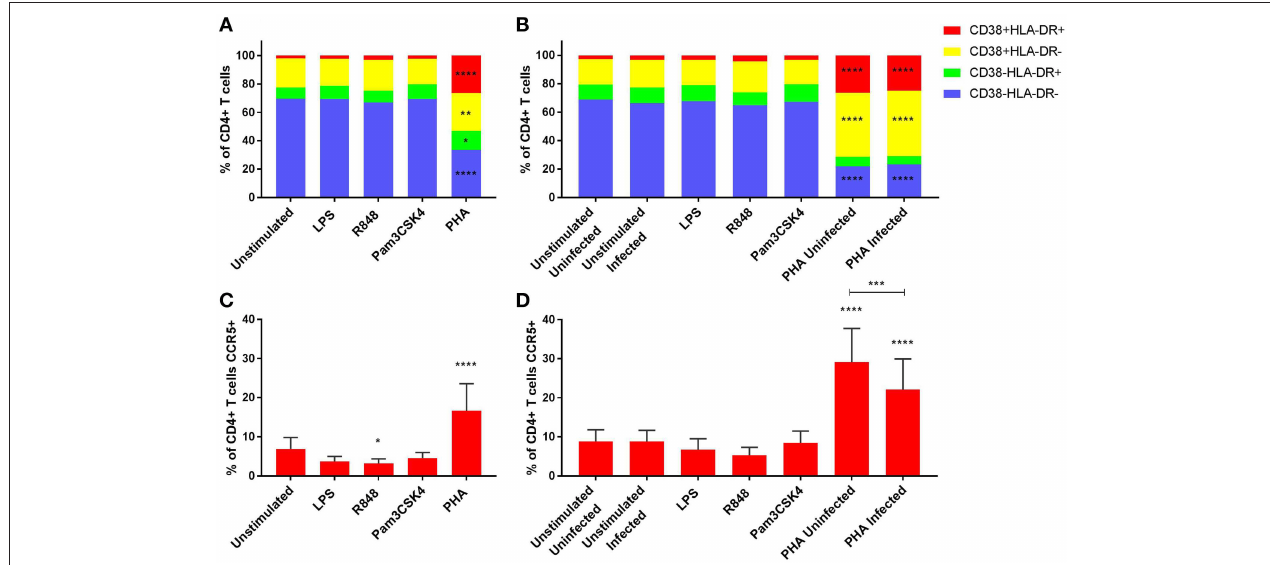
FIGURE 1 | Activation profiles (A,B) and CCR5 expression (C,D) of CD4 + T cells on day 3 prior to HIV infection (A,C) and day 5 post HIV infection (B,D) . PHA was used at a final concentration of 10 µ g/ml. TLR agonists were used at a final concentration of 2 µ g/ml. A repeated measures two-way ANOVA with Dunnett’s multiple comparisons test was used for immune activation, and an ordinary one-way ANOVA with a Dunnett’s multiple comparisons test for CCR5 expression. Significance is displayed as * p < 0.05, ** p < 0.01, *** p < 0.001, **** p ≤ 0.0001 compared to the unstimulated/unstimulated infected control, unless otherwise shown. Sample size, n = 5, 4 donors run in quadruplicate, 1 donor run in duplicate.